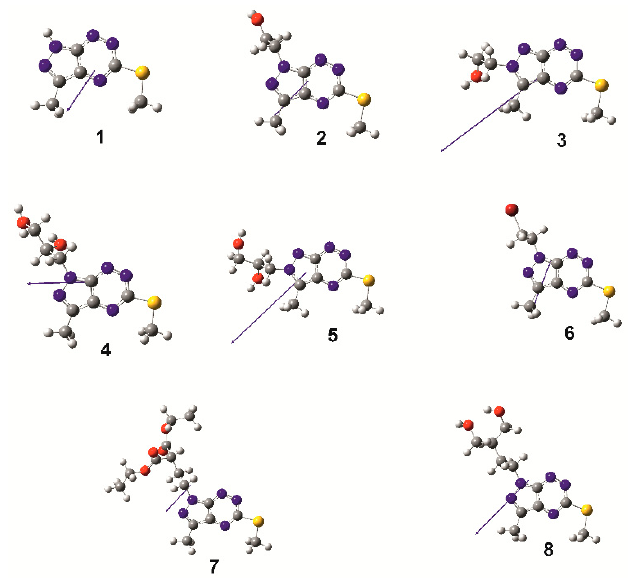
Figure 4. The molecules 1 – 8 with the vectors of dipole moment in the low-energy conformation obtained from calculations at the DFT/B3LYP/6-311++G(d,p) level.